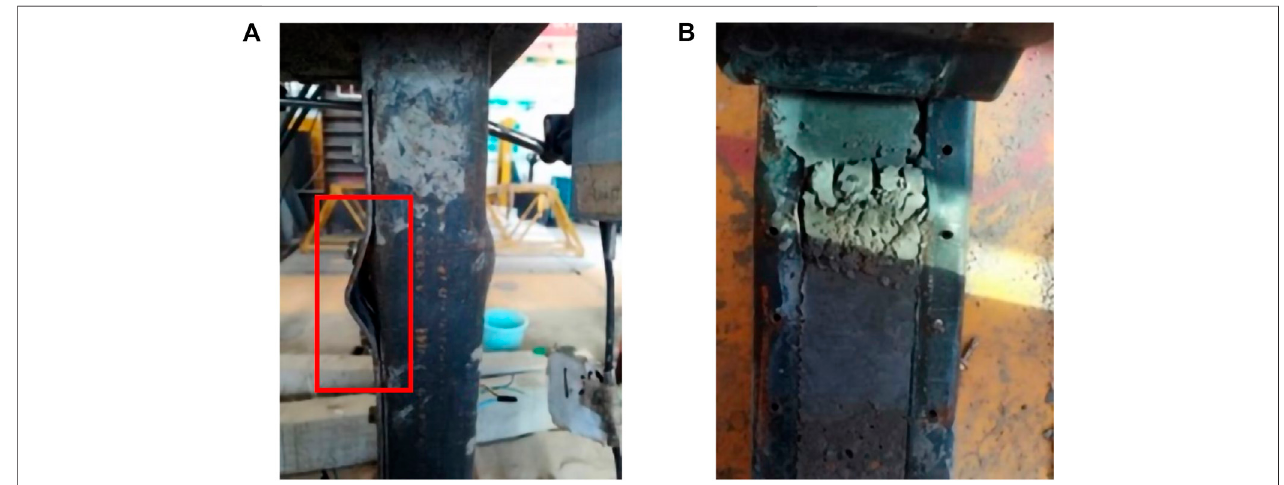
FIGURE 4 | (A) Local buckling on R50-2.2. (B) Crushed concrete in